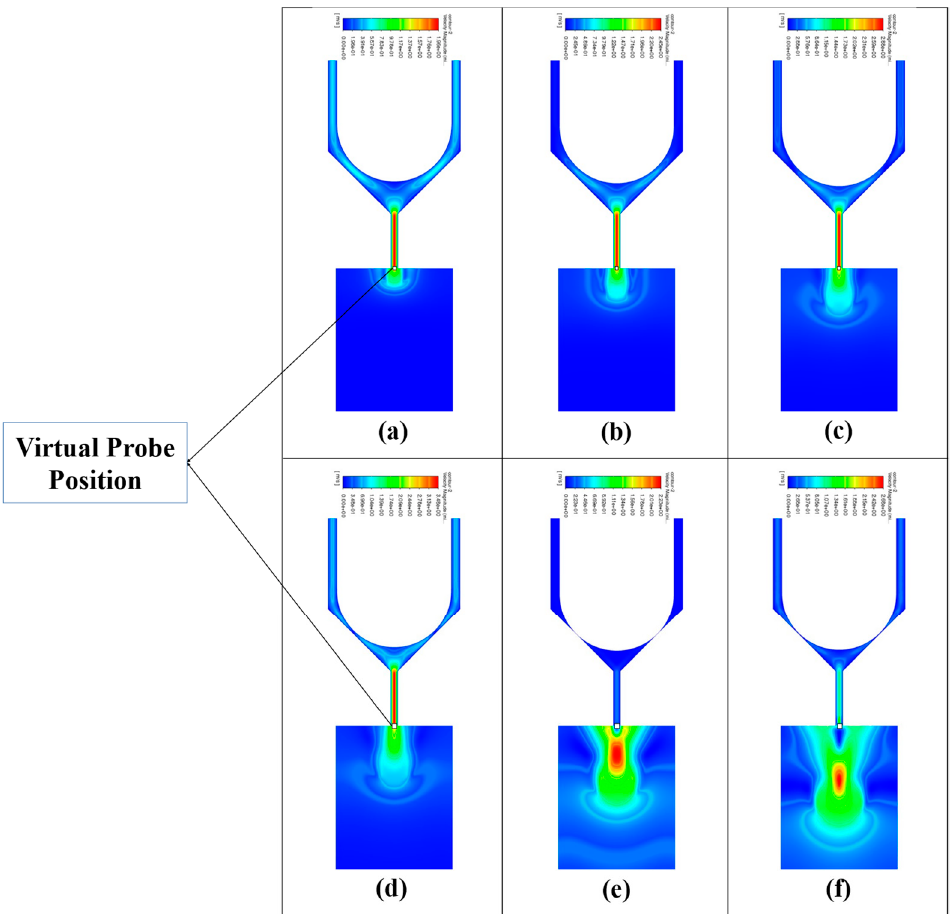
Figure 4. Velocity variation of the virtual probe (point P) in case 7 at different moments: ( a ) time = 0.0002 s, ( b ) time = 0.0004 s, ( c ) time = 0.0006 s, ( d ) time = 0.0008 s, ( e ) time = 0.001 s, ( f ) = 0.0012 s.